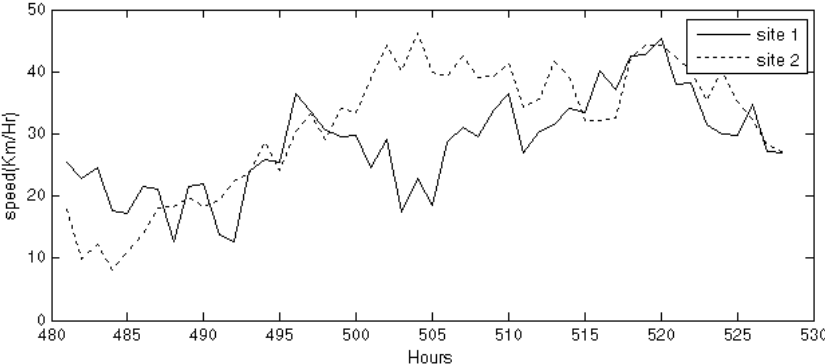
Figure 4. 2-day sample simulation of wind speeds for two sites with correlation of 0.56.